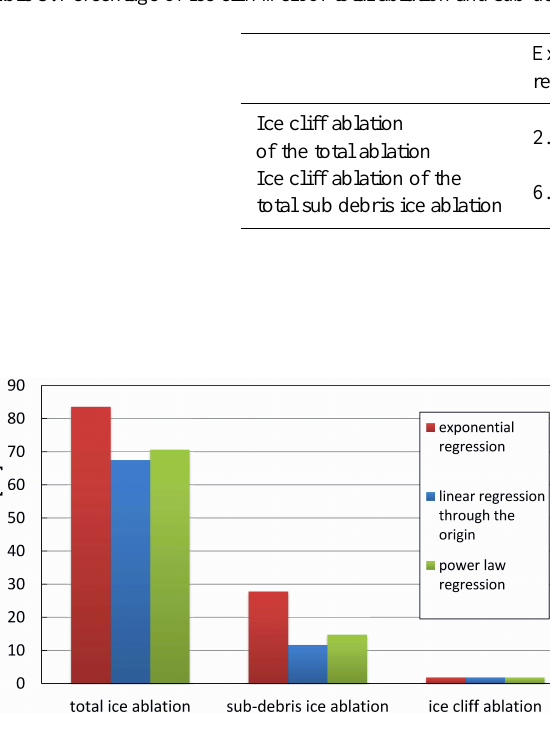
Fig. 7. (a) Distribution of calculated total ice ablation for the exponential regression during the time span of 1 May 2010 to 31 October 2010. (b) Difference in ablation for the linear regression through the origin relative to the exponential regression. (c) Difference in ablation for the power law regression relative to the exponential regression. Table 3. Percentage of ice cliff melt of total ablation and sub-debris ablation respectively.